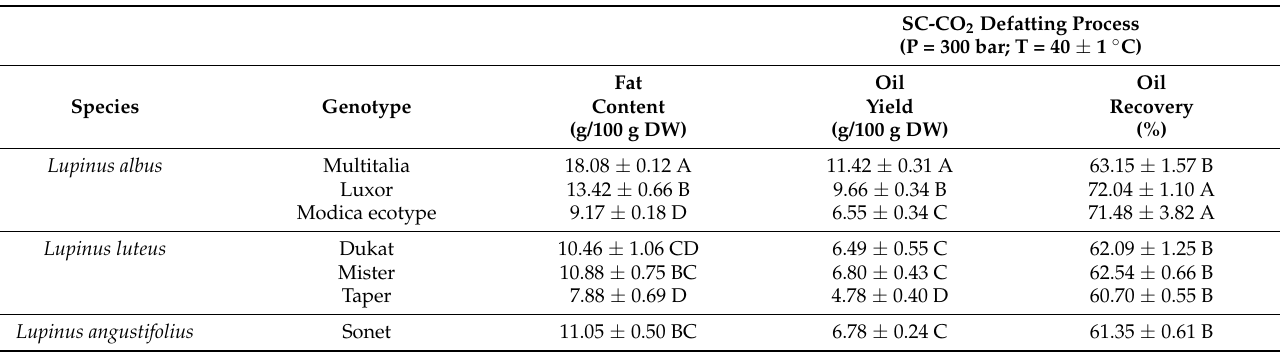
Table 3. Total fat content and experimental results of the different Lupinus spp. genotypes subjected to the SC-CO 2 defatting process.